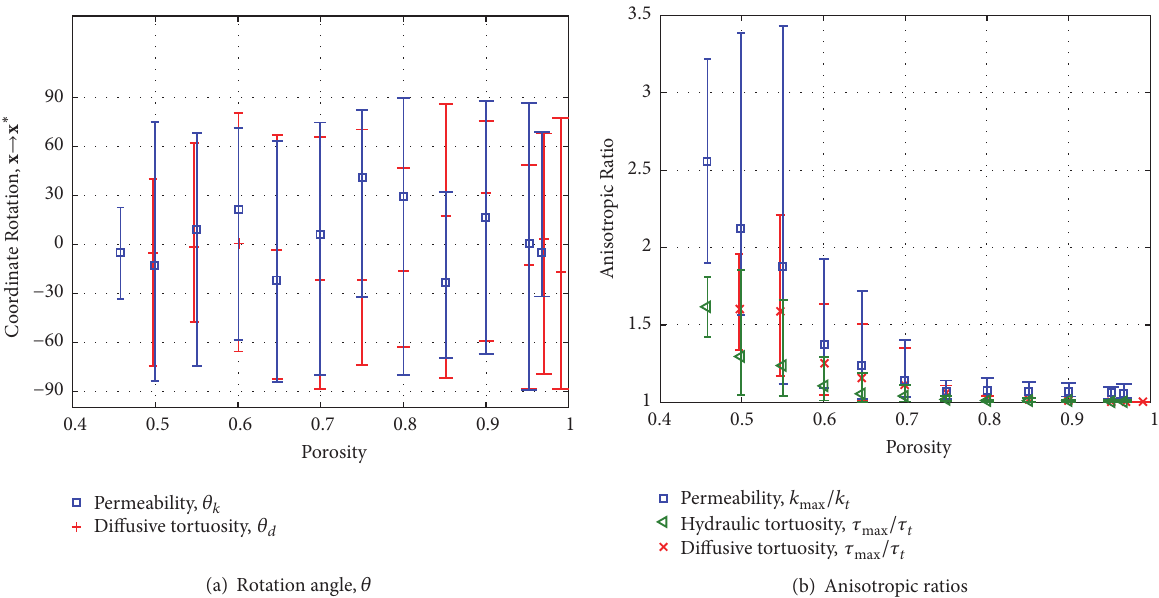
Figure 16: Anisotropic ratios in geometries comprised of randomly distributed squares: (a) rotation to obtain diagonal tensors ( k ∗ and 𝜏 ∗ 𝑑 ) is independent of porosity; (b) anisotropic ratios of diagonal tensors and anisotropic ratio of hydraulic tortuosity. At lower porosities ( 𝜙 < 0.6 ), anisotropic properties have been